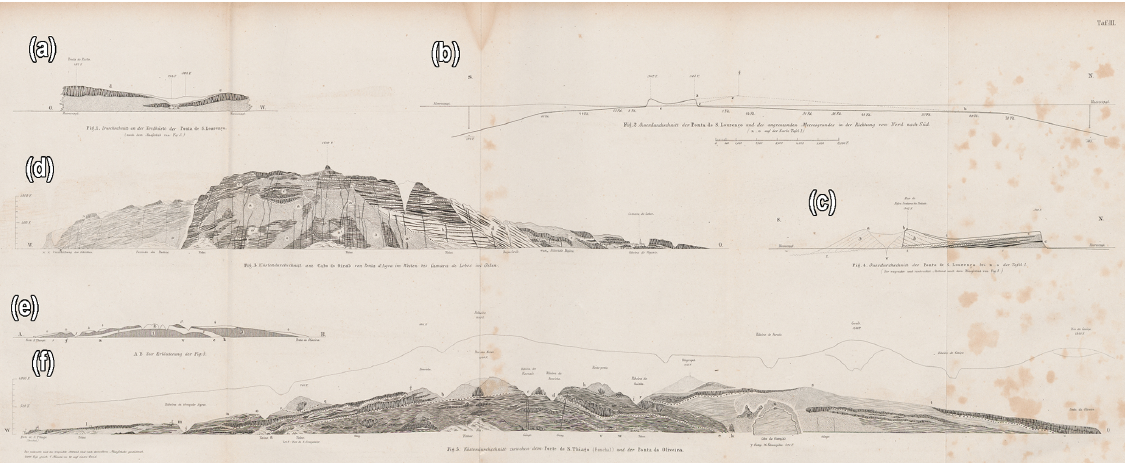
Figure 7. Hartung and Mayer (1864), plate III, portraying geological sketches of Madeira and the Madeira archipelago. (a, b, c) Sketches from the eastern part of Madeira at the Ponta de São Lourenço. (a) A section of the north cliff depicting the lithology. (b) N–S cross section. (c) More details of the cross section in (b) , including a stratigraphy and a reconstruction of the sea-eroded pyroclastic cone of Senhora da Piedade. (d, e, f) Drawings of the southern coast of Madeira. (d) Sea cliff from Cabo Girão to Câmara de Lobos. (e) Stratigraphy of the sea cliff portrayed in (f) . (f) Sea cliff from Forte de São Tiago (Funchal) to Ponta da Oliveira (Caniço). The image is public domain and was digitalized by ETH-Bibliothek Zurich (https://www.e-rara.ch/zut/content/zoom/7222170, last access: 26 September 2021).